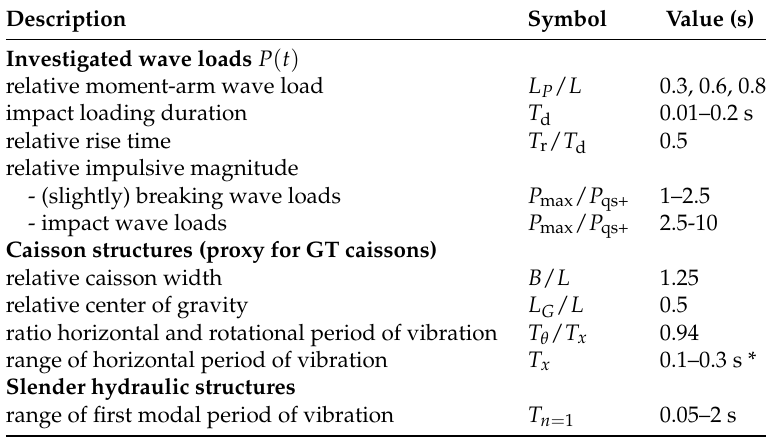
Table 1. Overview of input parameters adopted in this